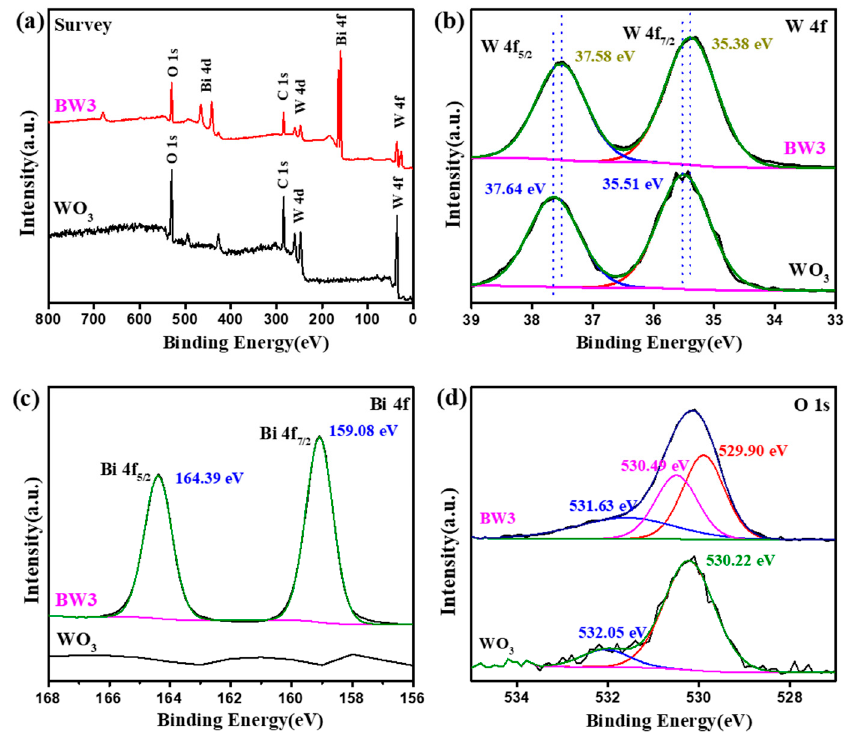
Figure 6. The X-ray photoelectron spectroscopy (XPS) spectra of WO 3 and BW3. ( a ) survey spectra, ( b ) W4f, ( c ) Bi4f, and ( d ) O1s.